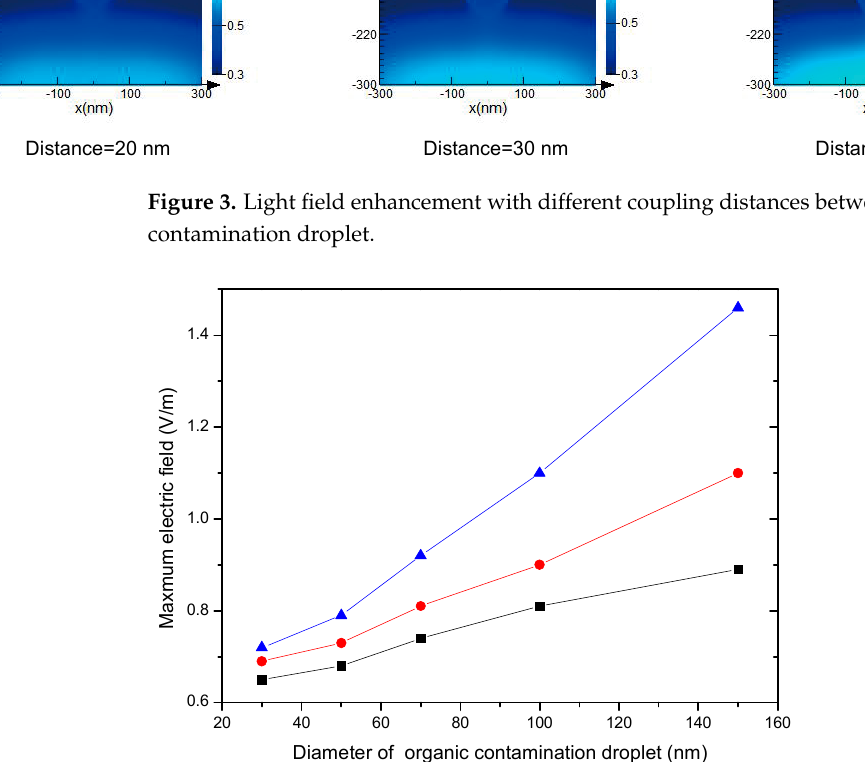
Figure 4. Light field variation with organic contamination droplets of different sizes. The blue, red, and black lines are the result of the different refractive indexes (1.5, 2.6, and 2.2, respectively) of the defect.